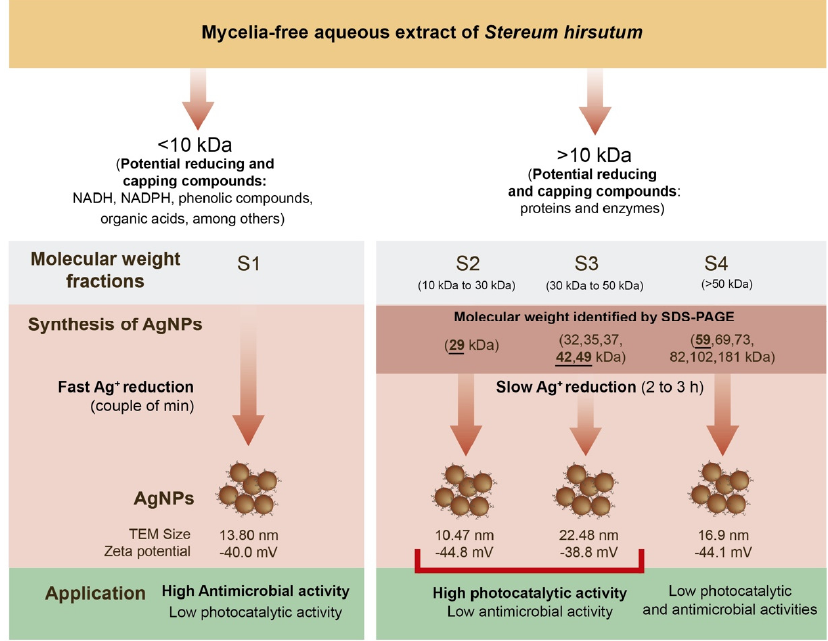
Figure 8. Synthesis of AgNPs by molecular weight fractions from mycelia-free aqueous extract of S. hirsutum.